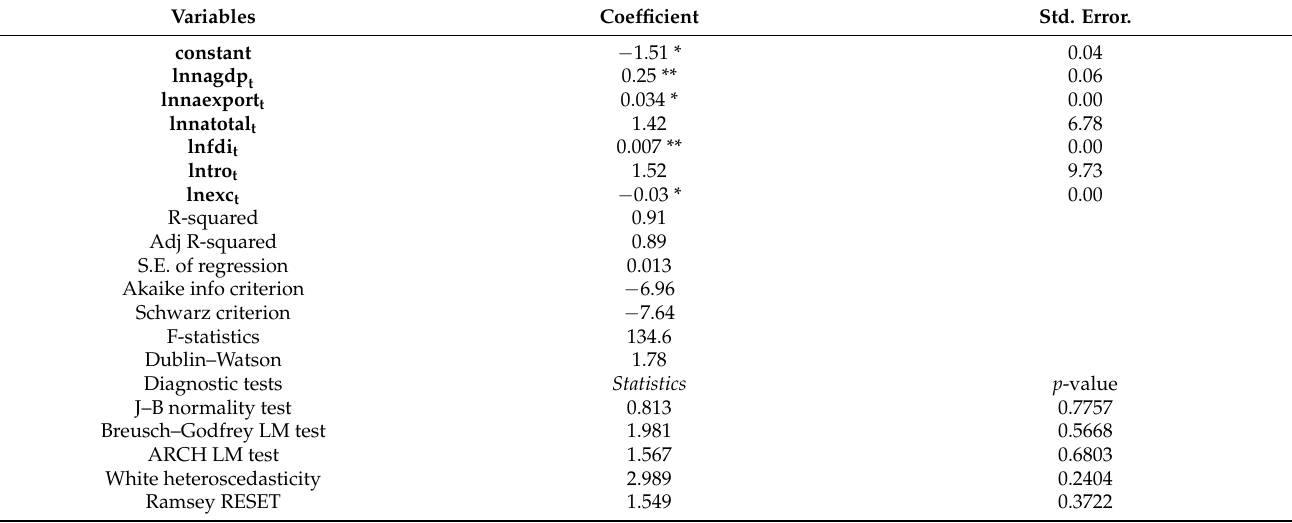
Table 6. Long-run results. Dependent variable—economic